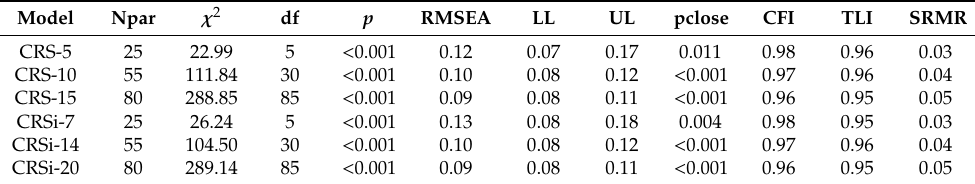
Table 5. Results of the confirmatory factor analyses with all versions of the